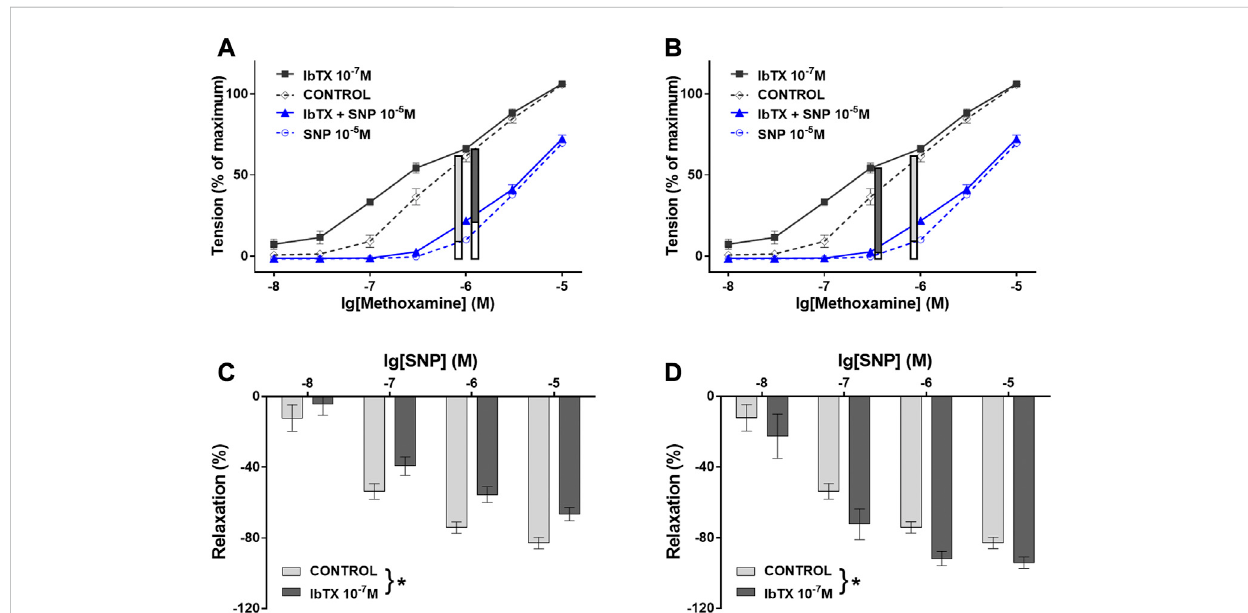
FIGURE 5 ContributionoftheBKchanneltotheanti-contractileeffectofSNPdependsontheconditionsusedforpre-contraction. (A) and (B) Vesseltensionin theabsenceofIBTXandSNP(CONTROL),inthepresenceofIBTXalone(IBTX),inthepresenceofSNPalone(SNP),andinthecombinedpresenceofIBTX and SNP (IBTX + SNP) at 10 – 5 M SNP. (A) Selection of similar levels of submaximal pre-contraction in the absence and presence of IBTX when IBTX had almost no contractile effect (black curves, 10 – 6 M MX);relaxing effect of10 – 5 MSNP (bluecurves) ( fi lled parts ofthe vertical bars) in theabsence and presence of IBTX presented also in (C) together with the effect of other concentrations of SNP (* - two-way ANOVA control vs. IBTX: p < 0.05); (B) Selection of similar levels of submaximal pre-contraction in the absence and presence of IBTX when IBTX had a considerable contractile effect (black curves, 3*10 – 7 M and 10 – 6 M MX); relaxing effect of 10 – 5 M SNP (blue curves) ( fi lled parts of the vertical bars) in the absence and presence of IBTX presented also in (D) together with the effect of other concentrations of SNP (* - two-way ANOVA control vs. IBTX: p < 0.05); Reproduced and modi fi ed with permission from (Schmid et al.,